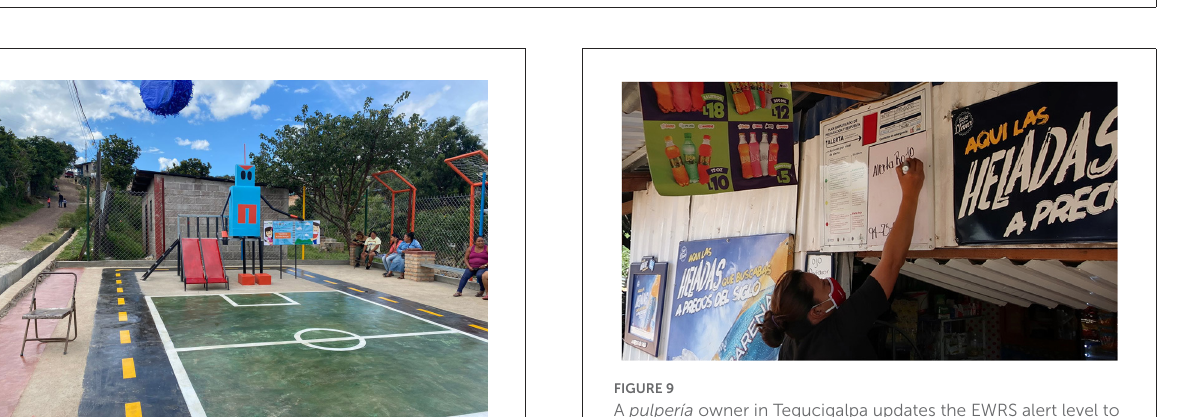
FIGURE8 Playground constructed in a risk zone in an informal settlement. Credit: GOAL.